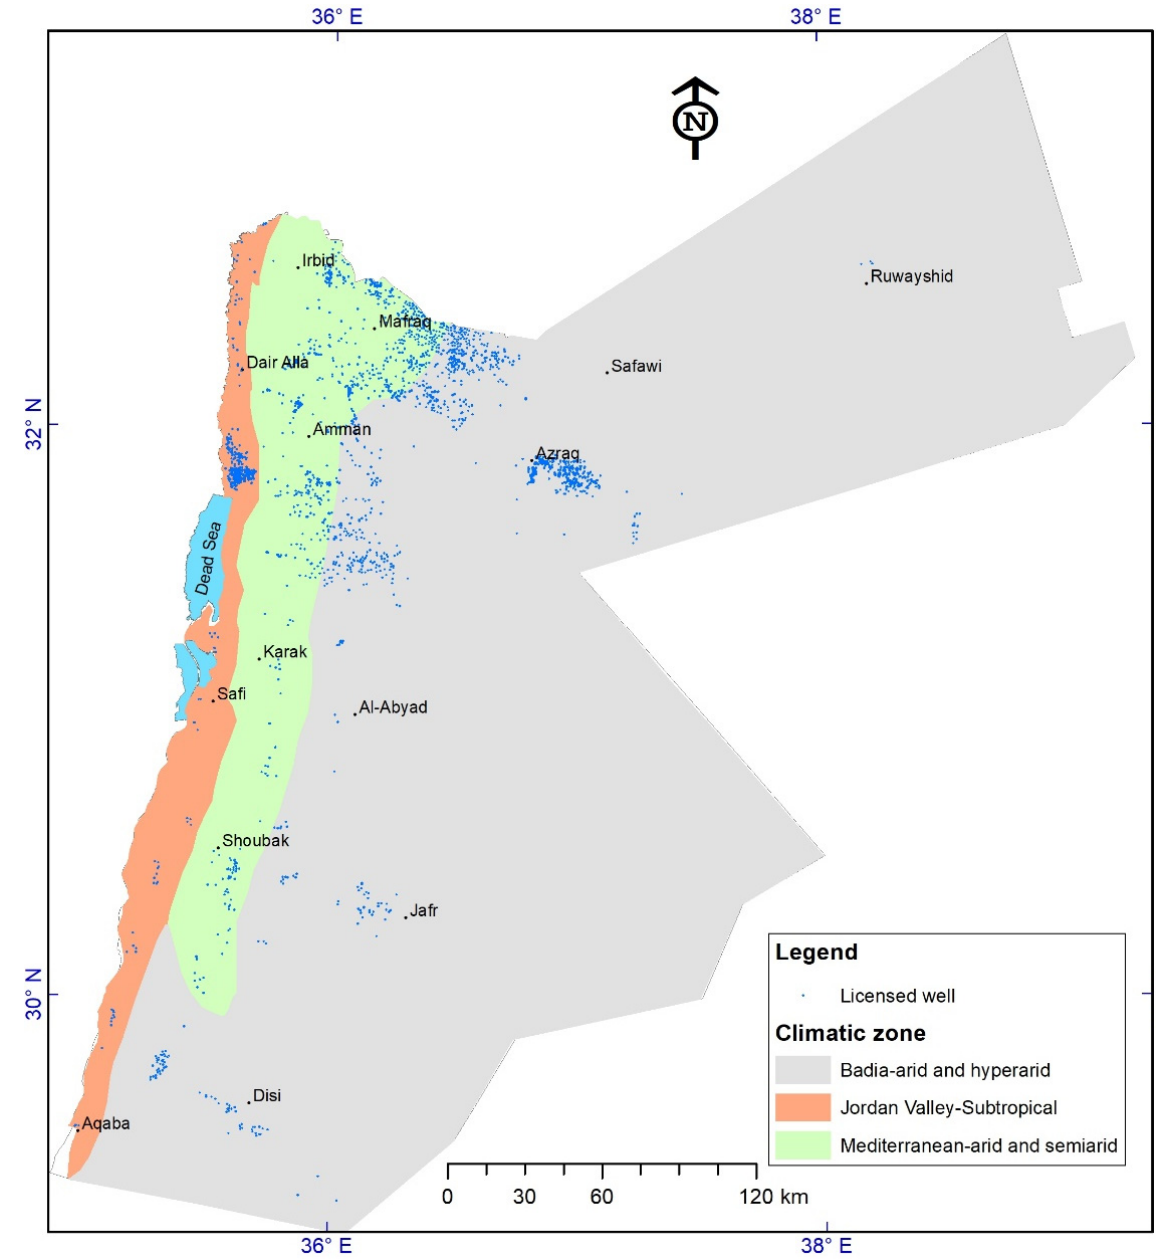
Figure 1. Locations of the study areas’ groundwater irrigation wells in Jordan.